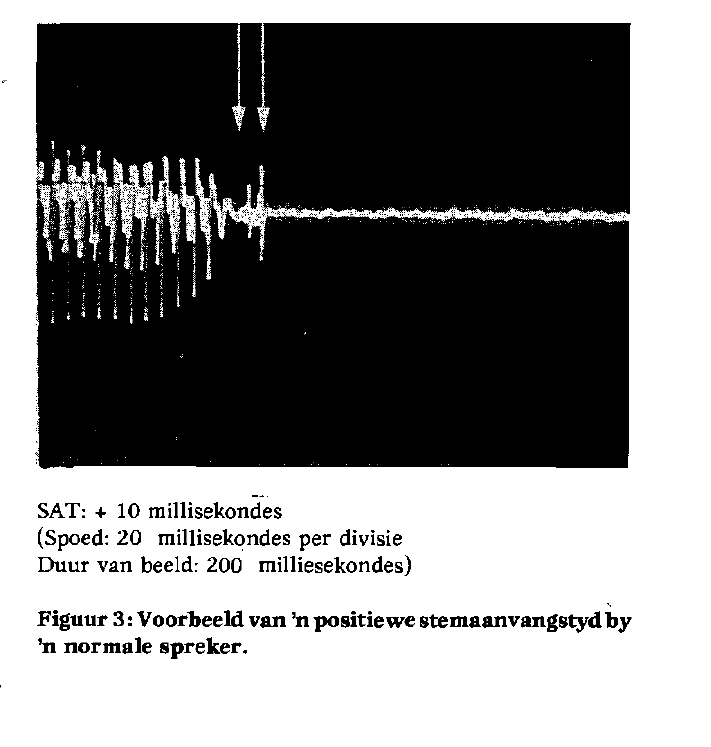
SAT: + 10 millisekondes (Spoed: 20 millisekondes per divisie Duur van beeld: 200 milliesekondes) Figuur 3: Voorbeeld van 'n positiewe stemaanvangstyd by 'n normale